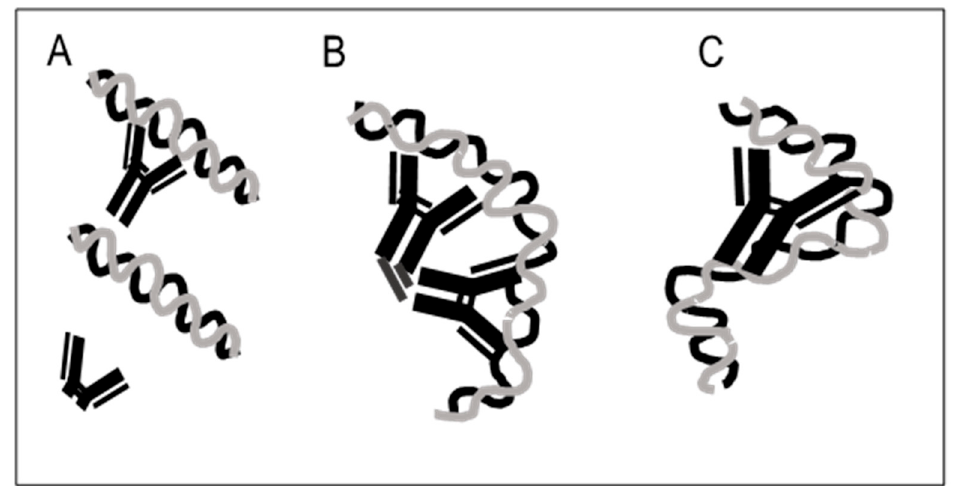
Figure 1. The role of Fc in the binding of anti-DNA antibodies to DNA. This figure illustrates possible mechanisms by which the Fc portion of an IgG anti-DNA can contribute to binding to DNA. Panel ( A ) indicates that the fully intact IgG can bind to DNA while the F(ab’)2 fragment is unable to do so. The failure of the F(ab’)2 to bind could result from an alteration in the Fab binding sites by an allosteric change. Panel ( B ) indicates that Fc-dependent monogamous bivalency results from interaction of both Fc portions, leading to cross-linking of IgG molecules. Panel ( C ) indicates that DNA interacts with both Fab binding sites as well as sites on the Fc portion, effectively creating a third binding site.